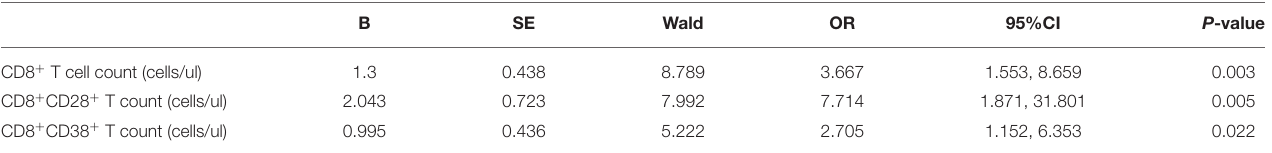
TABLE 4 | Cox regression of lymphocyte subsets related parameters and